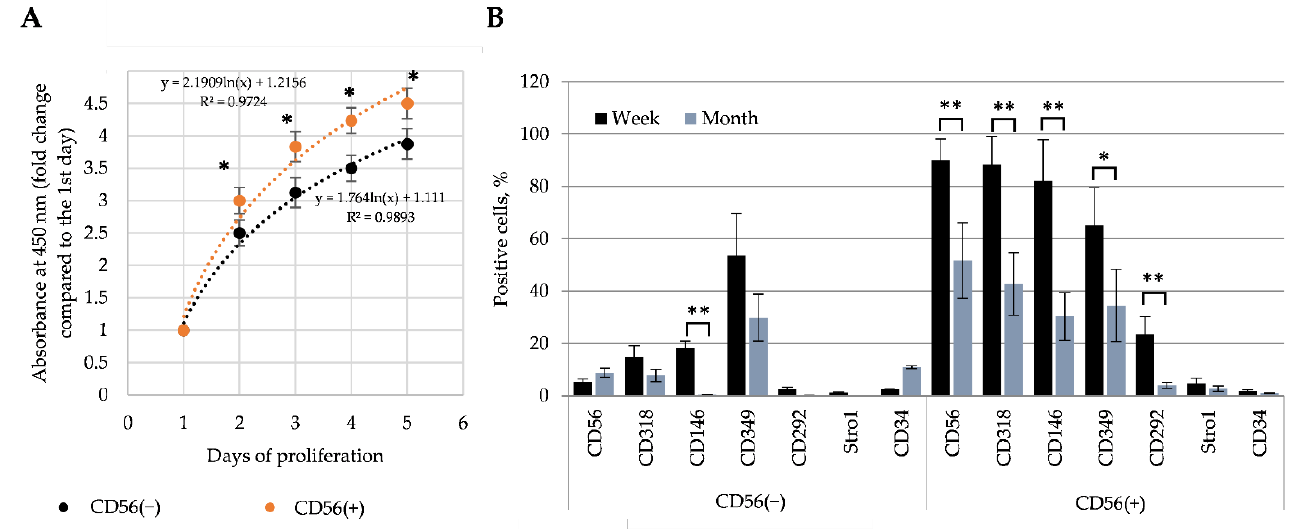
Figure 5. The proliferation and surface markers of CD56( − ) and CD56(+) cells. ( A ) Proliferation of human skeletal muscle CD56( − ) and CD56(+) subpopulations; ( B ) surface marker profile in CD56( − ) and CD56(+) cells after one week and one month of the cell culturing in vitro. Data are shown as mean ± standard deviation (SD) from not less than three repeats ( n = 3) and three cell cultures calculated using the Excel software and are significant at * p ≤ 0.05 and ** p ≤ 0.01 levels.